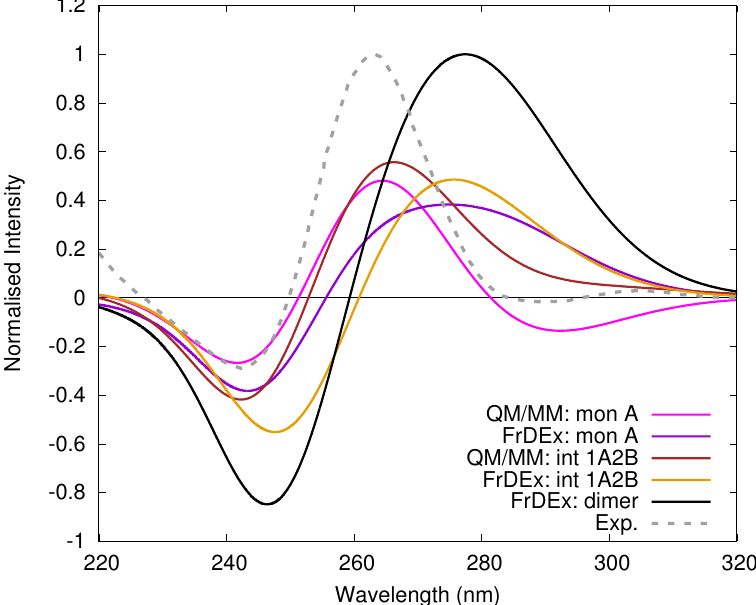
Figure 9. ECD spectra of the parallel GQ dimer T30695 from experiment [37] and computed by FrDEx, with low energy peaks normalised to 1. We also show the T30695 GQ “monomer” A, and the interface consisting of 1 tetrad of A and 2 of B (int 1A2B) computed by FrDEx and PCM/MM/TD- M05-2X/6-31G(d), both of which are normalised using the same value as the FrDEx spectrum of the